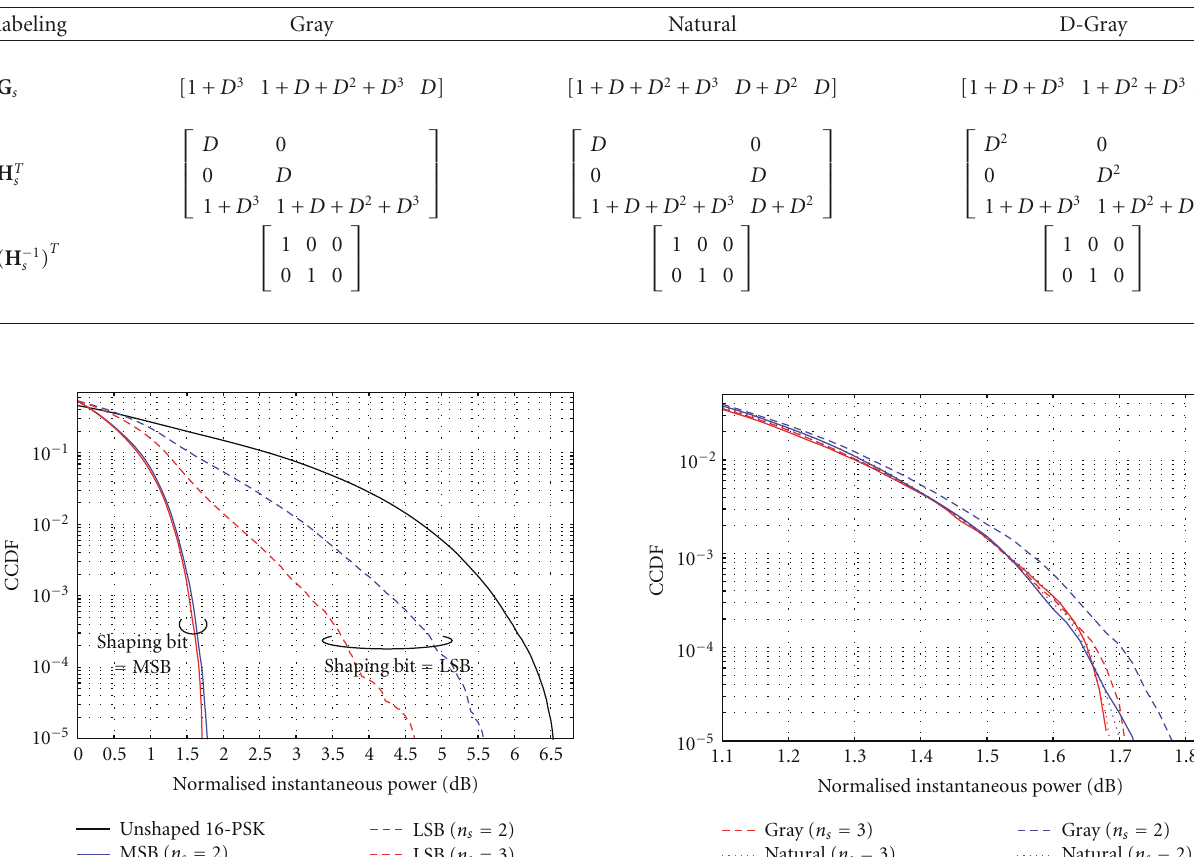
Table 2: The optimum parameters for n s = 3 with 32-PSK.